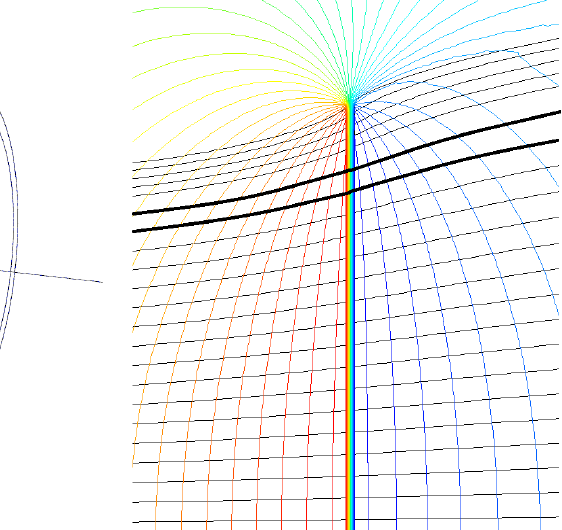
Figure 3. ( Left ): An annular element bounded by four surfaces: Inlet, outlet, outer surface _ out , inner surface s _ in . ( Right ): Cross-section axi-symmetric CFD domain part surrounding the disk. Black streamlines show the annular element radial expansion (one is highlighted black), colored lines are isobar contours. Note that due to the wake (streamline) expansion and the pressure gradients in the disk’s vicinity, the pressure integrals in Equation (16) will be non ‐ zero.